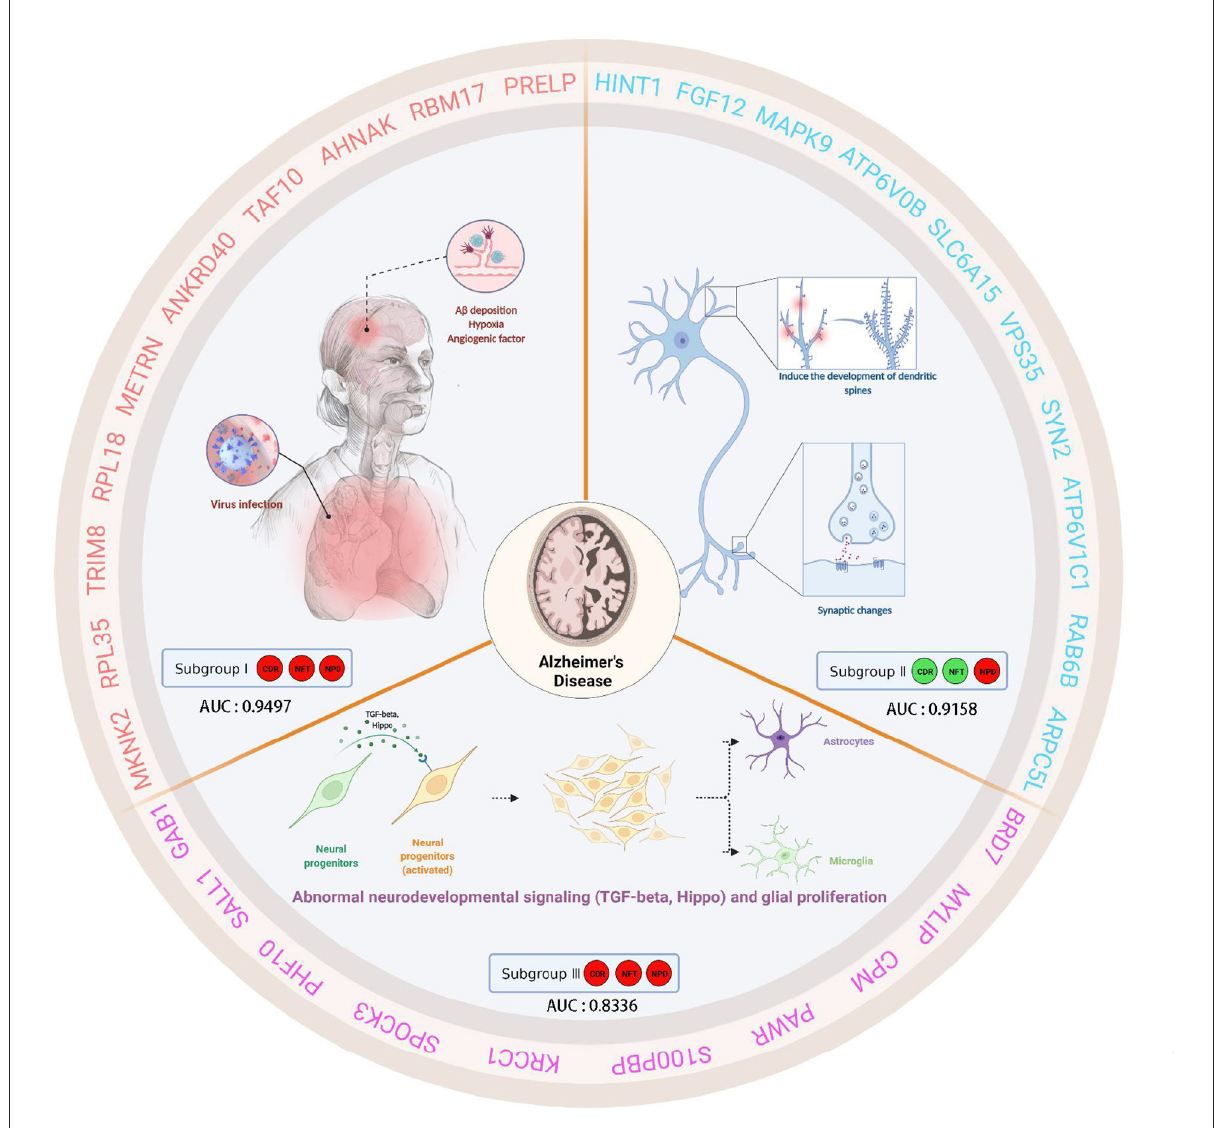
FIGURE12 This schematic diagram describes the clinical characteristics, biological significance, and hub genes of three subgroups of AD. Subgroup I showed high CDR, NFT, and NPD, which were closely related to virus infection. Furthermore, subgroup I showed characteristic genes associated with hypoxia factors and angiogenesis factors. Subgroup II, low CDR, NFT, and high NPD, had minor synaptic damage. In subgroup II, spinous dendritic development and synaptic plasticity were upregulated, axonal vesicle transport and synaptic transmission were upregulated, autophagy and phagosome acidification were increased, and postsynaptic membrane transmitter receptors (especially NMDA receptors and AMPA receptors associated with long-term potentiation, post-scaffold protein PSD95) were upregulated, and intracellular signaling was active. Subgroup III presented high CDR, NFT, and NPD, which was similar to familial AD due to PSEN1-specific amplification. Subgroup III showed TGF-beta and active Hippo signaling pathway, self-renewal of neural stem cells, the proliferation of neural progenitor cells, differentiation and activation of glial cells, etc. We speculated that these changes in subgroup III were